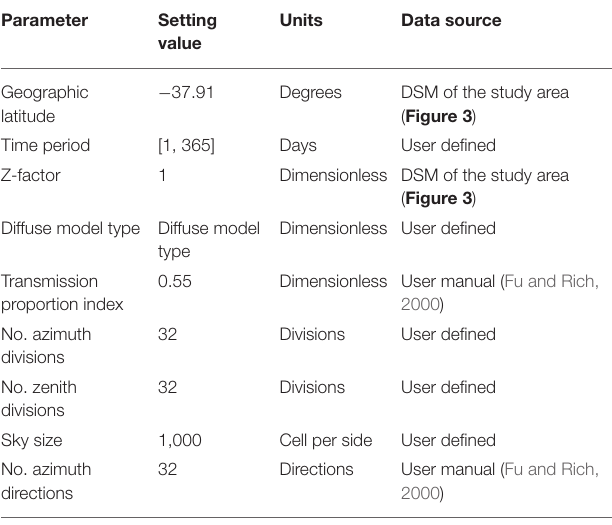
TABLE 1 | Solar Analyst parameters (Radosevic et al., 2020).